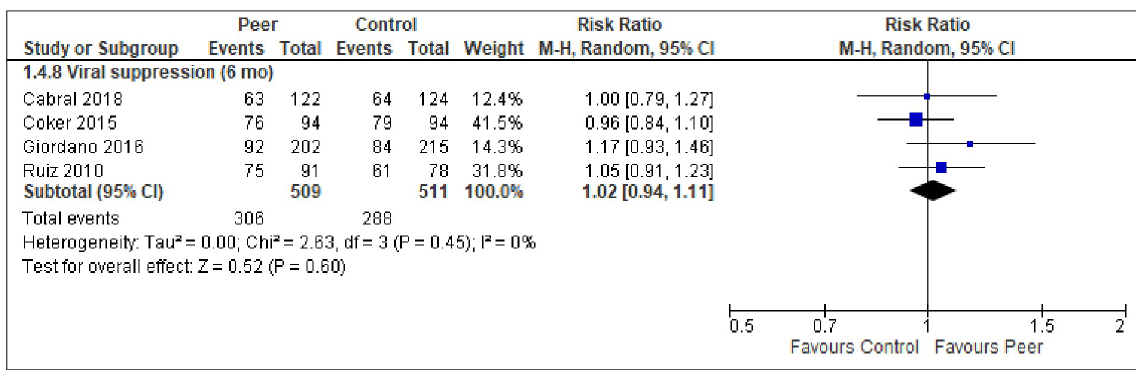
Fig 6. Meta-analysis of outcome viral